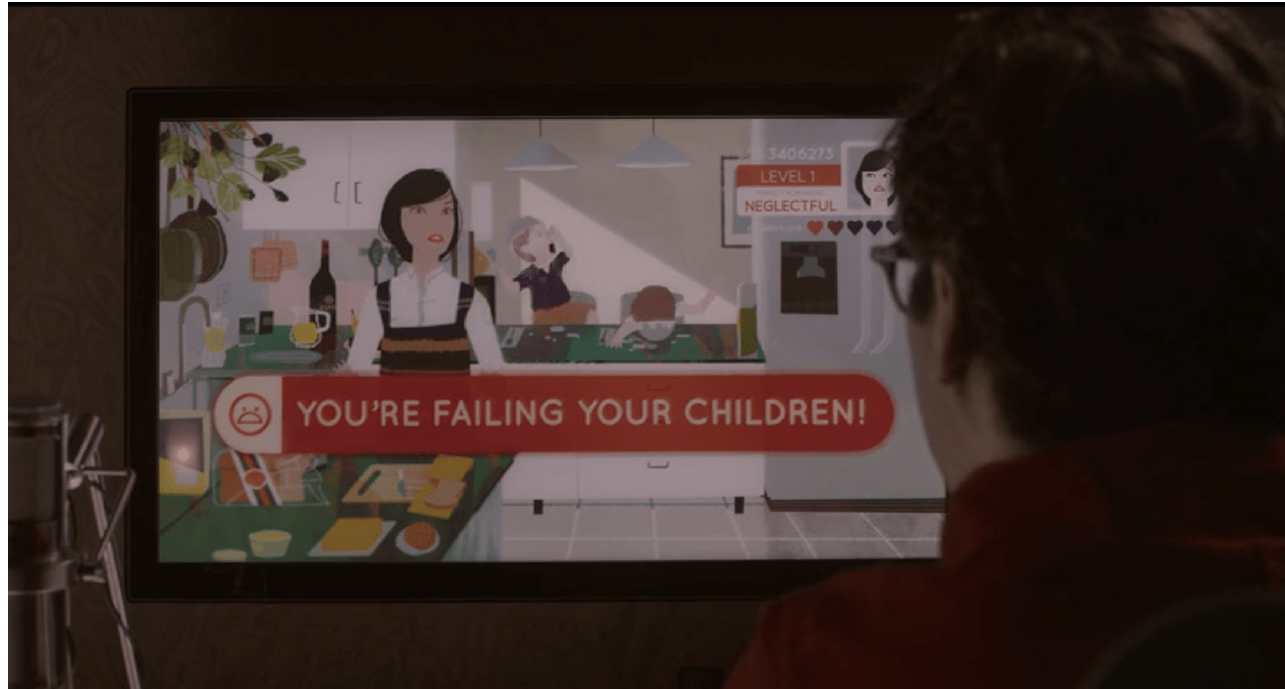
Figure 4. Theo plays Perfect Mom . (Screenshot created by author).